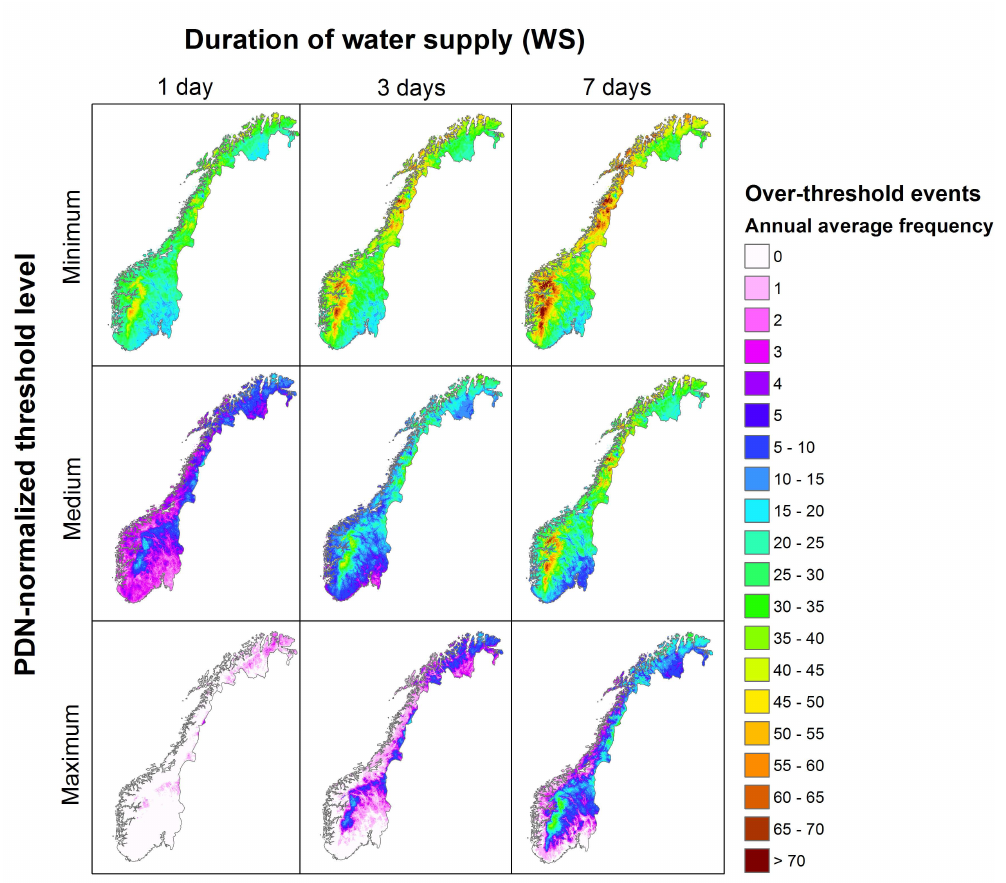
Fig. 8. Spatial distribution of the annual average frequency of over-threshold events calculated from the PDN-normalized minimum, medium and maximum ID threshold for 1 day, 3 days and 7 days duration of water supply.